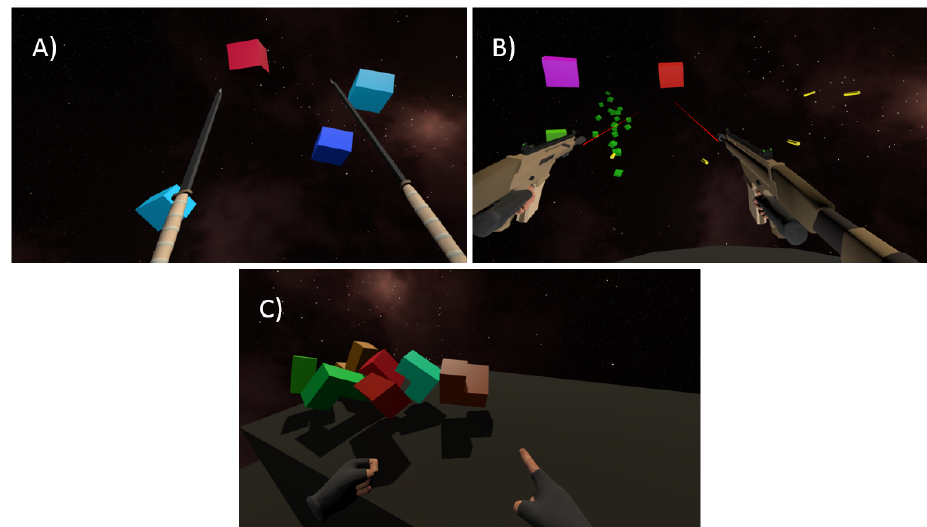
Figure 12. Screenshots from a prototype implementation of our test application concept depicting different VR interaction mechanics: ( A ) slice; ( B ) shoot; ( C ) pick and